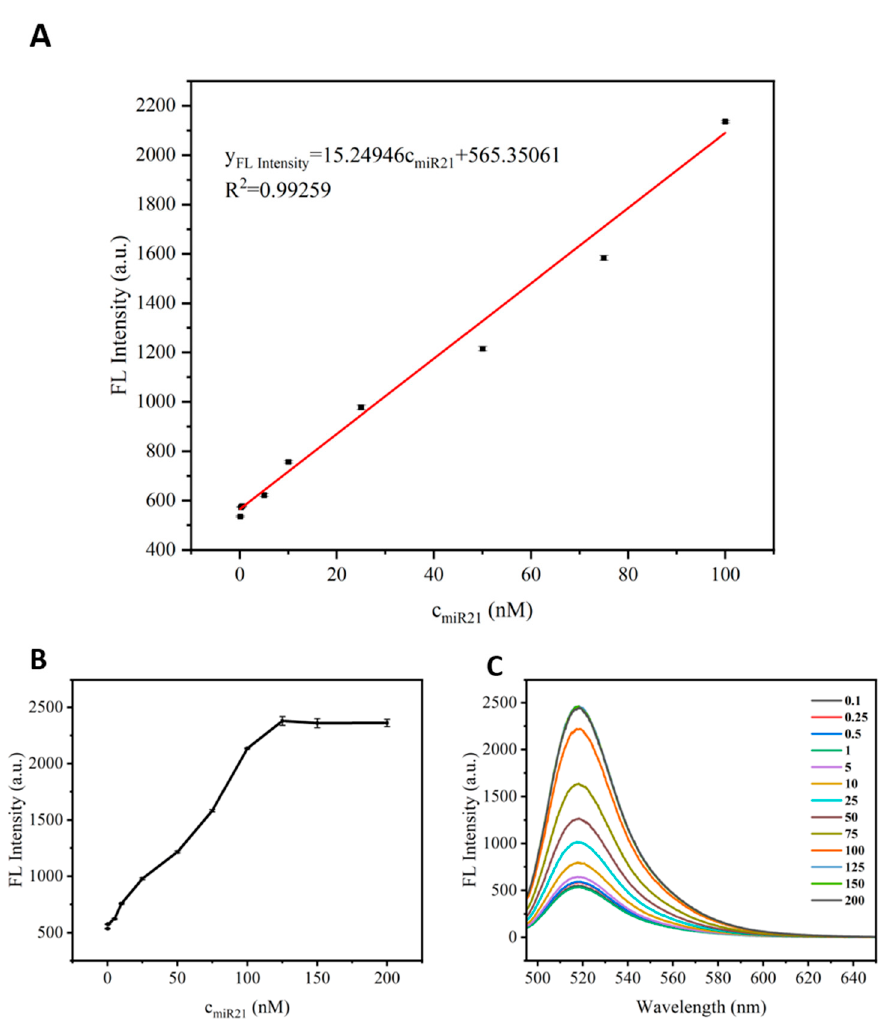
Figure 2. In vitro detection miR21 by the sequence optimized dsDNA probe. ( A ) The linear relation- ship between FL intensity and c miR21 ranging from 0.1 to 100 nM at a dsDNA probe concentration of 100 nM, ( B ) fluorescence intensity of DNA probes with the miR21 at indicated concentrations and ( C ) the corresponding fluorescence spectra.